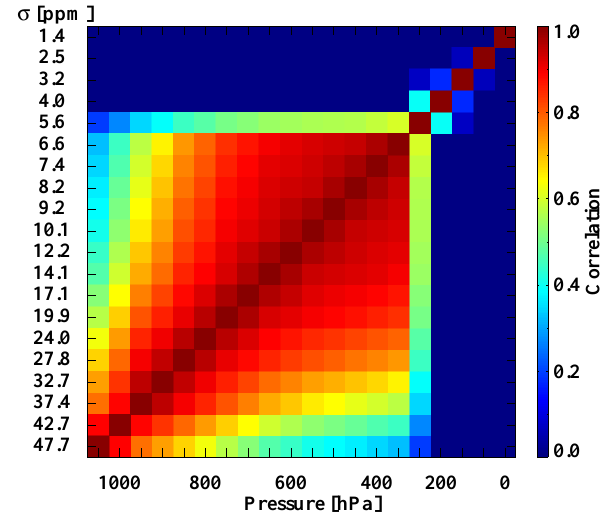
Fig. 2. A priori CO 2 correlation matrix. The colors represent the error correlation between CO 2 concentrations at different pressures, arranged TOA to surface from top to bottom and right to left. The left-hand column gives square root of the diagonal elements of the covariance